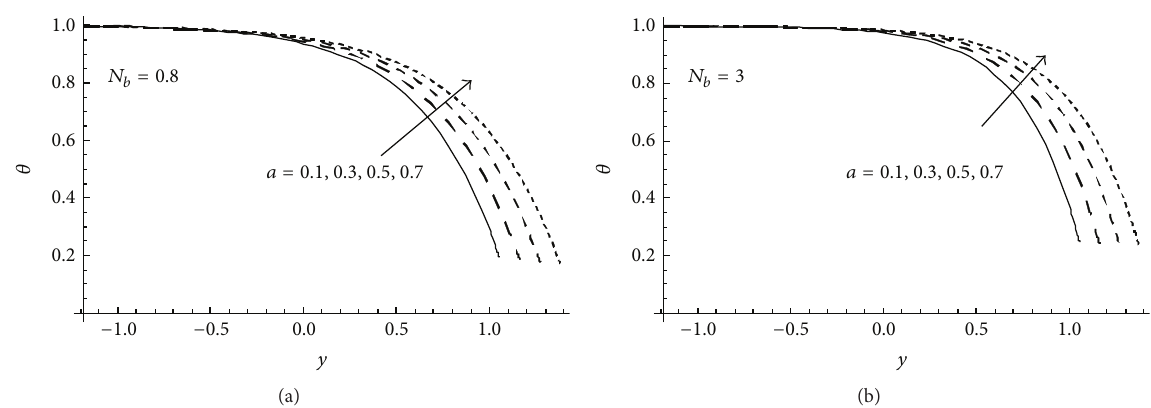
Figure 2: Variation of temperature profile at different values of 𝑎 when 𝑁 𝑡 = 5 , 𝑑 = 1 , 𝑏 = 0.5 , 𝑥 = 1 , 𝜙 = 0.2 , 𝛾 = 0.1 , and 𝛾 1 = 0.1 for (a) = 0.8 and (b) 𝑁 = 3 . 𝑁 𝑏 𝑏